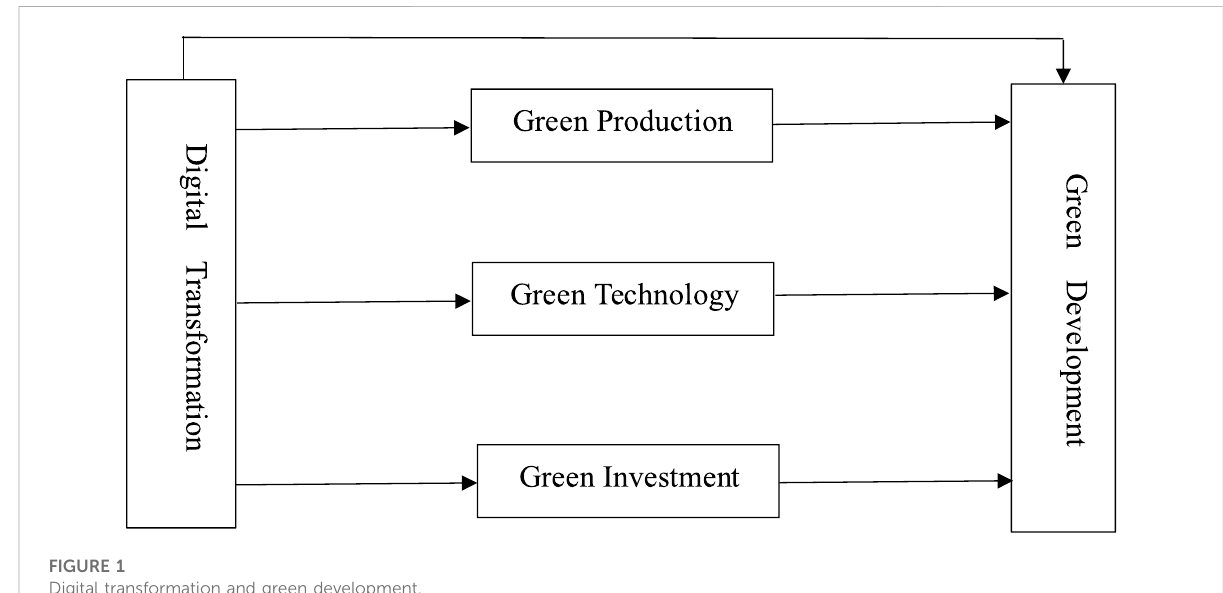
FIGURE 1 Digital transformation and green